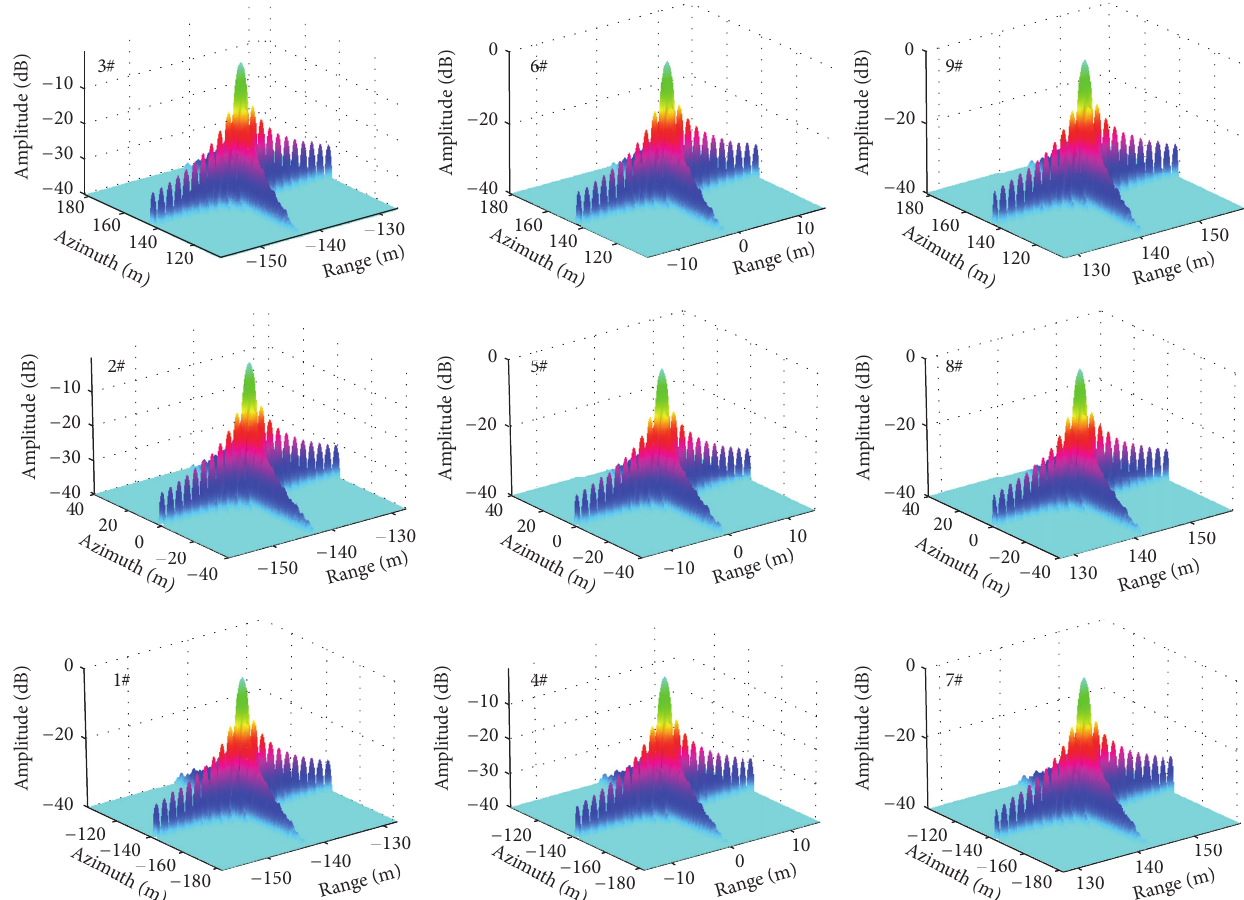
Figure 11: Point spread function of frequency stepped SAR with FDEM and DBP-FFBPA, dynamic range: 40